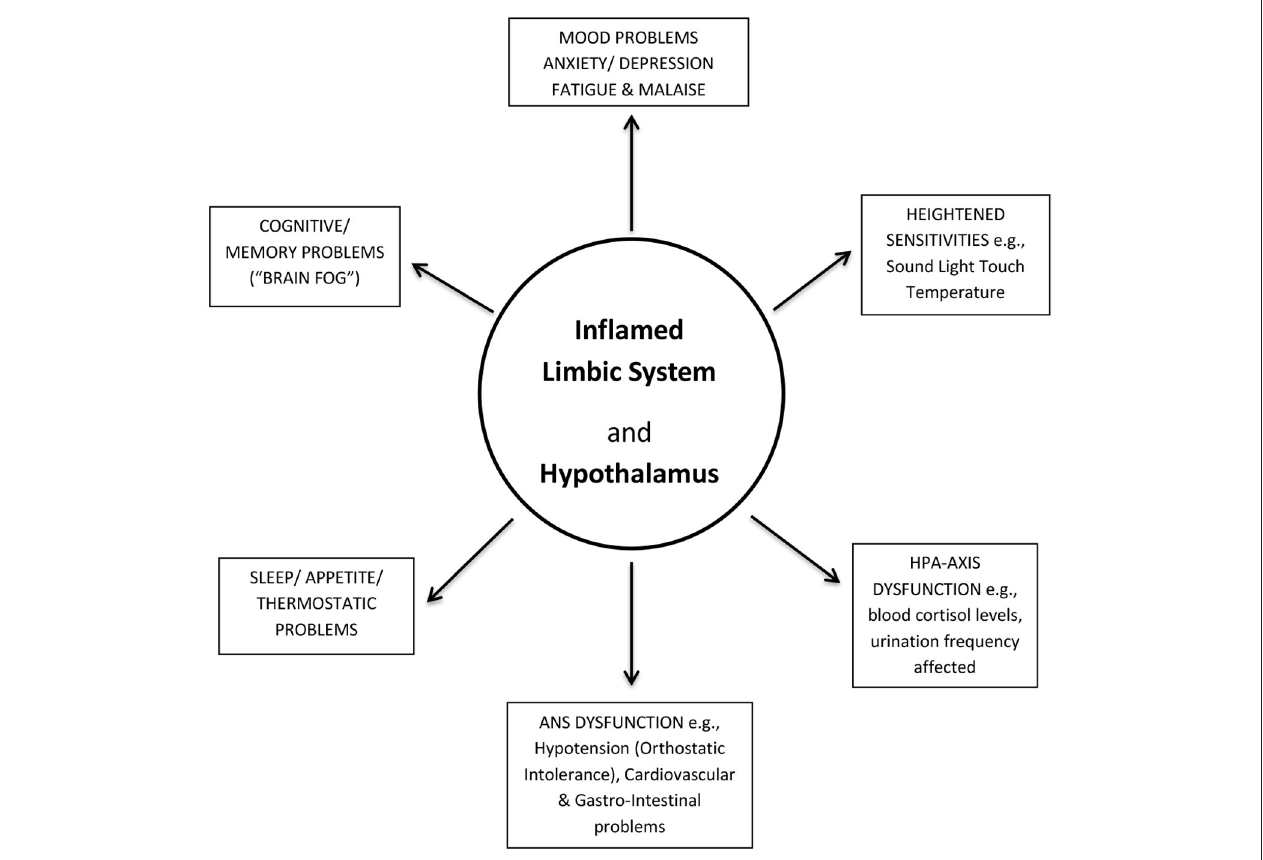
FIGURE 2 | Post-COVID-19 Fatigue Syndrome (PCFS) symptoms explained. An inflamed (dysfunctional) limbic system and its hypothalamus could account for the majority of the wide-range of ME/CFS-like symptoms in PCFS. ANS, Autonomic Nervous System; HPA-axis, Hypothalamic-Pituitary-Adrenal axis.